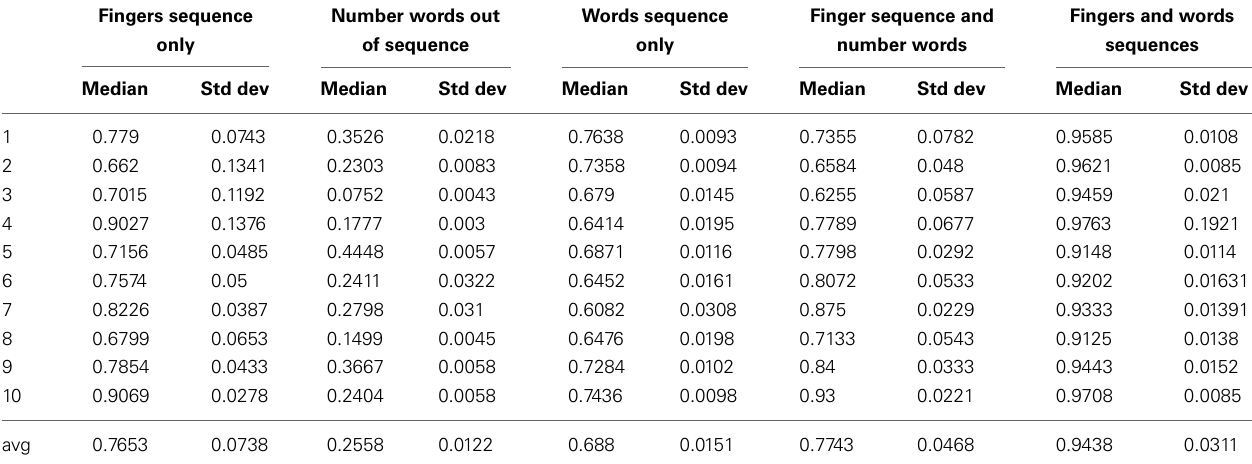
Table 3 | Likelihood of number classes with different training datasets. Fingers